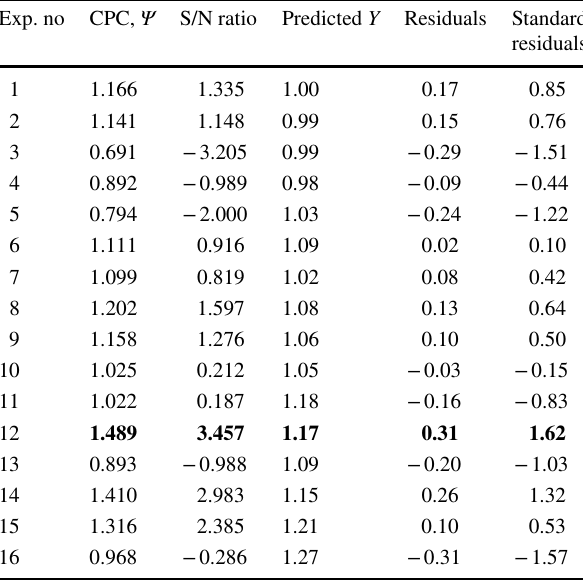
As per Table 6, the accountability proportion (AP) val- ues of three principal components, like surface roughness